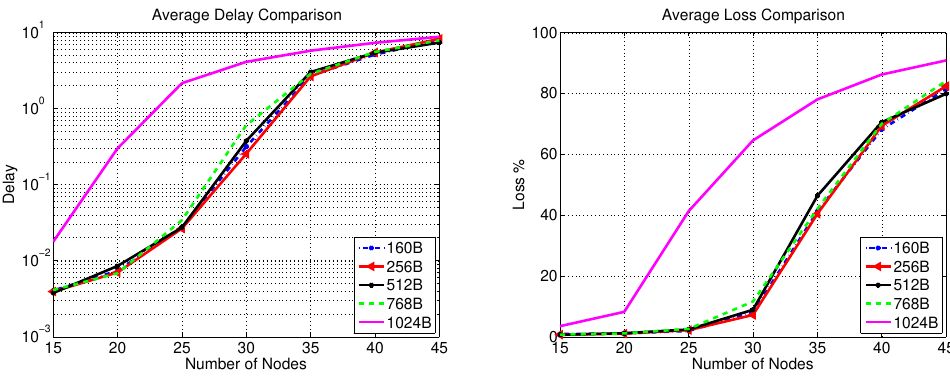
Figure 8. SS-Gateway communication performance (2048-bit key